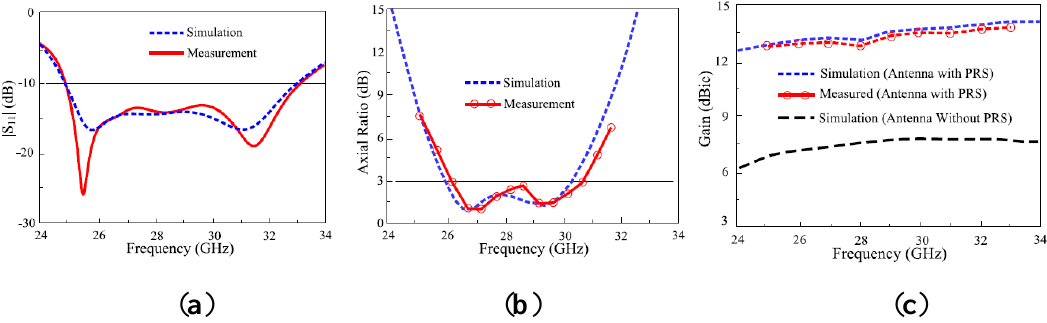
Figure 13. Measured and simulated results of the CP RCA reported in [42]: ( a ) Reflection coefficient; ( b ) AR; ( c )